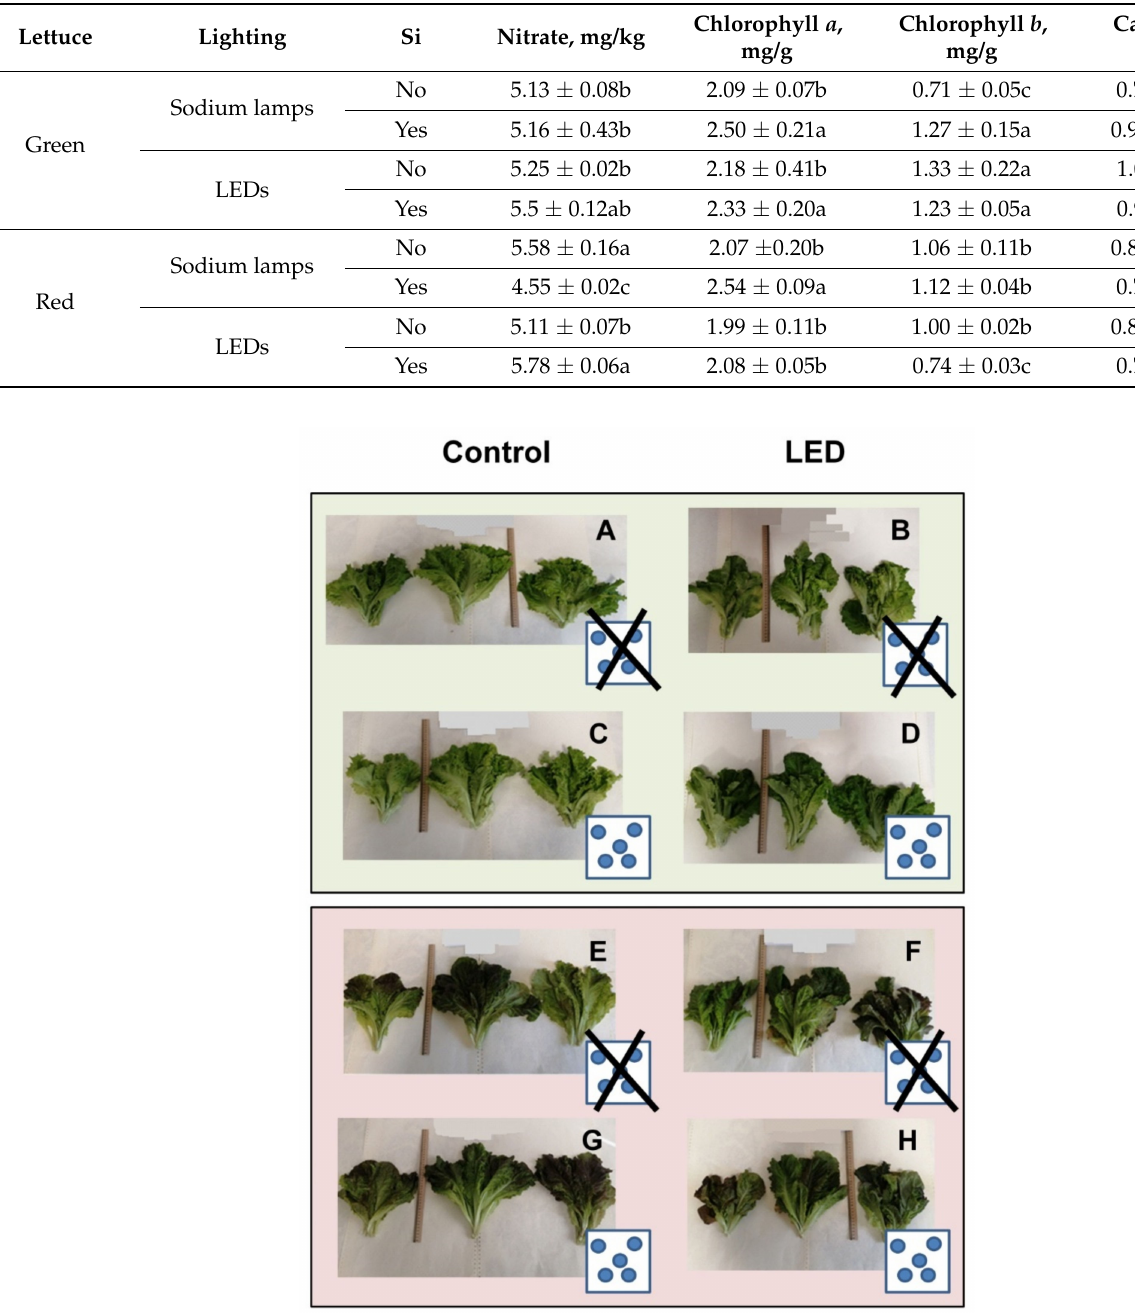
Figure 2. Comparison of the appearance of green ( A – D ) and red ( E – H ) lettuce on the 45th day of cultivation. Plants after sodium lamp illumination are on the left, after LED illumination on the right. ( C , D , G , H ) are the samples grown with Si fertilizer. ( A , B , E , F ) were grown without Si fertilizer. The same advantage of sodium over LED lighting, about 12.2%, was revealed compar- ing the number of leaves of both varieties, LSD = 1.26 (Table S5). The red lettuce showed a tendency for more intensive leaf formation